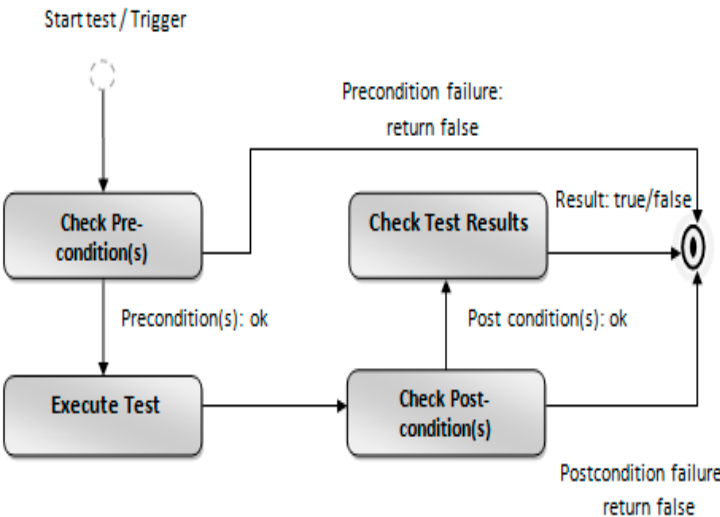
Figure 7. Fundamental activities for a test.